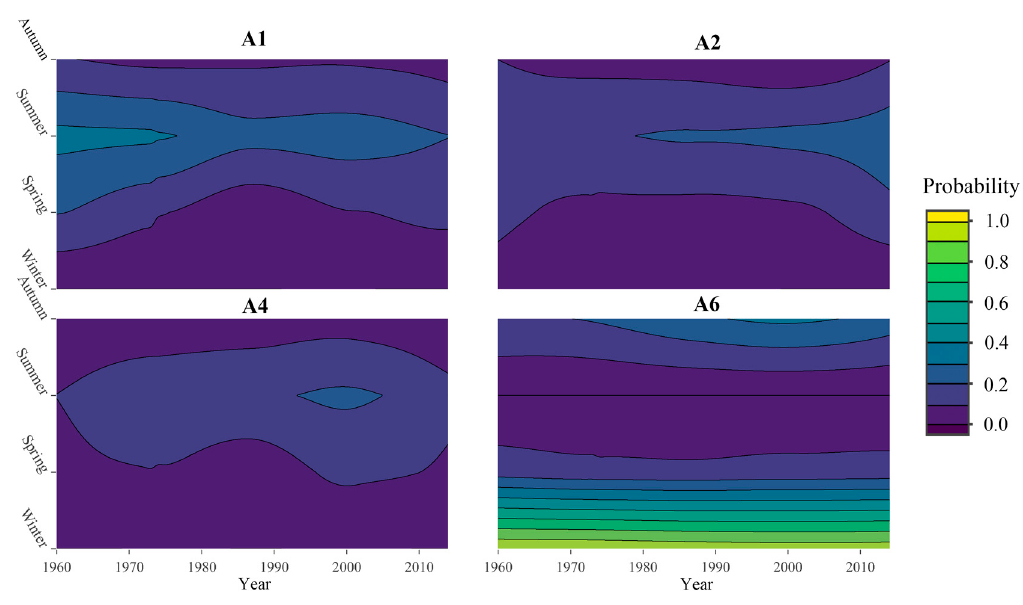
Figure 6. Trends in probability of archetype occurrence for each season across years.